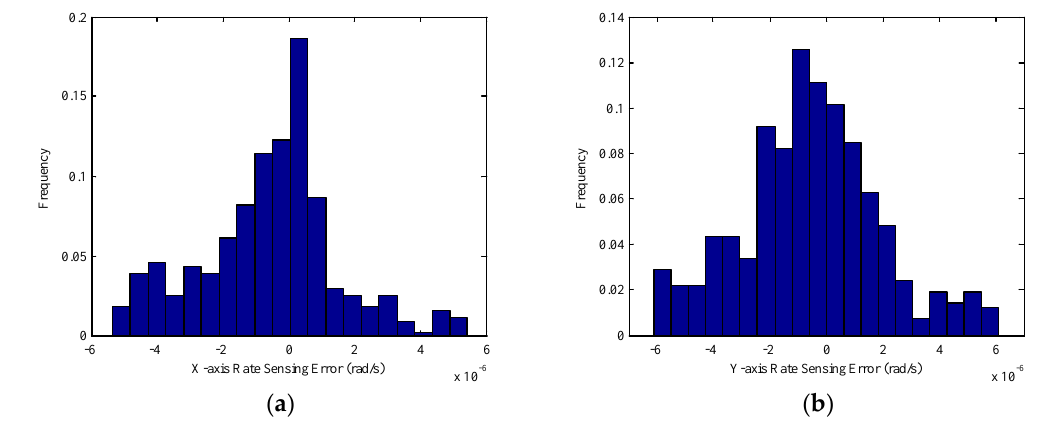
Figure 11. Histograms of Rate sensing errors: ( a ) X -axis; ( b ) Y -axis.